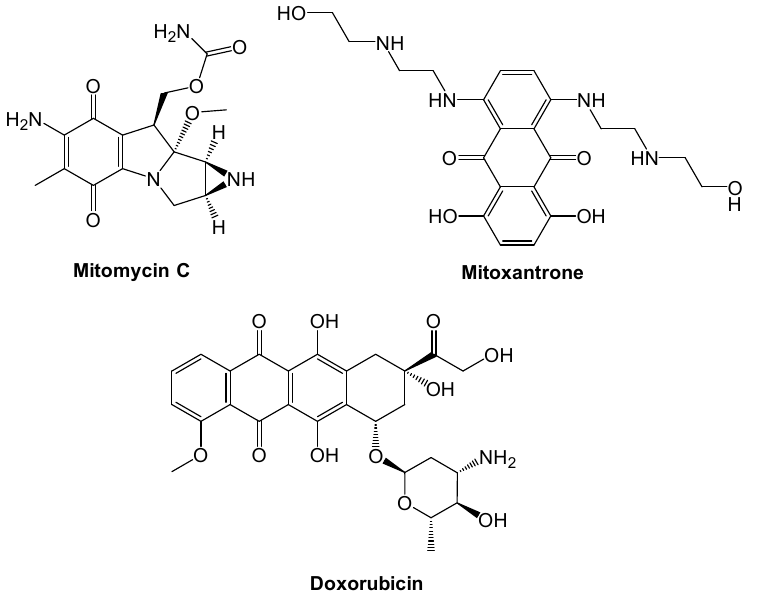
Figure 2. Mitomycin C, mitoxantrone, and doxorubicin, potential anticancer drugs the containing 1,4-quinone moiety.